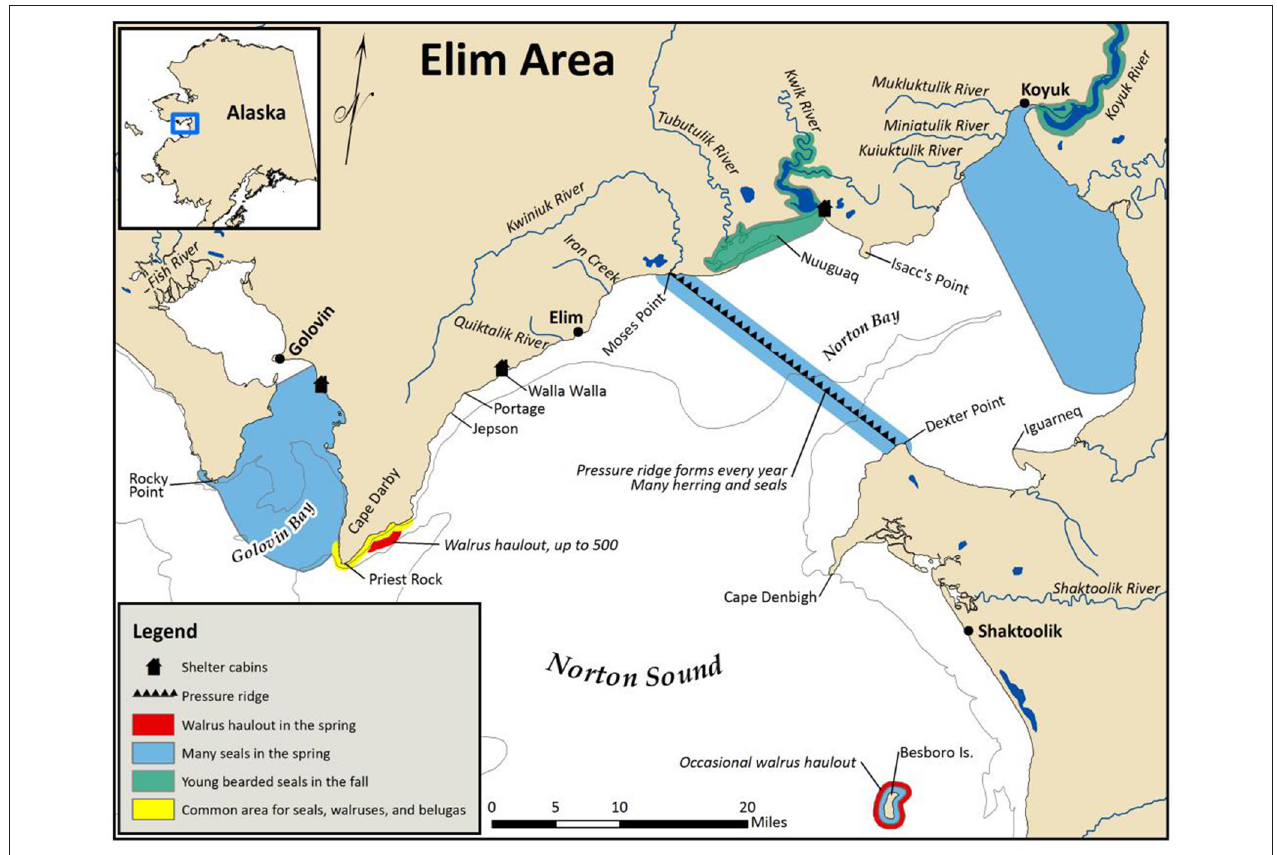
FIGURE 4 | Traditional knowledge about the movements and behavior of marine mammals near Elim, Alaska as described during interviews in February